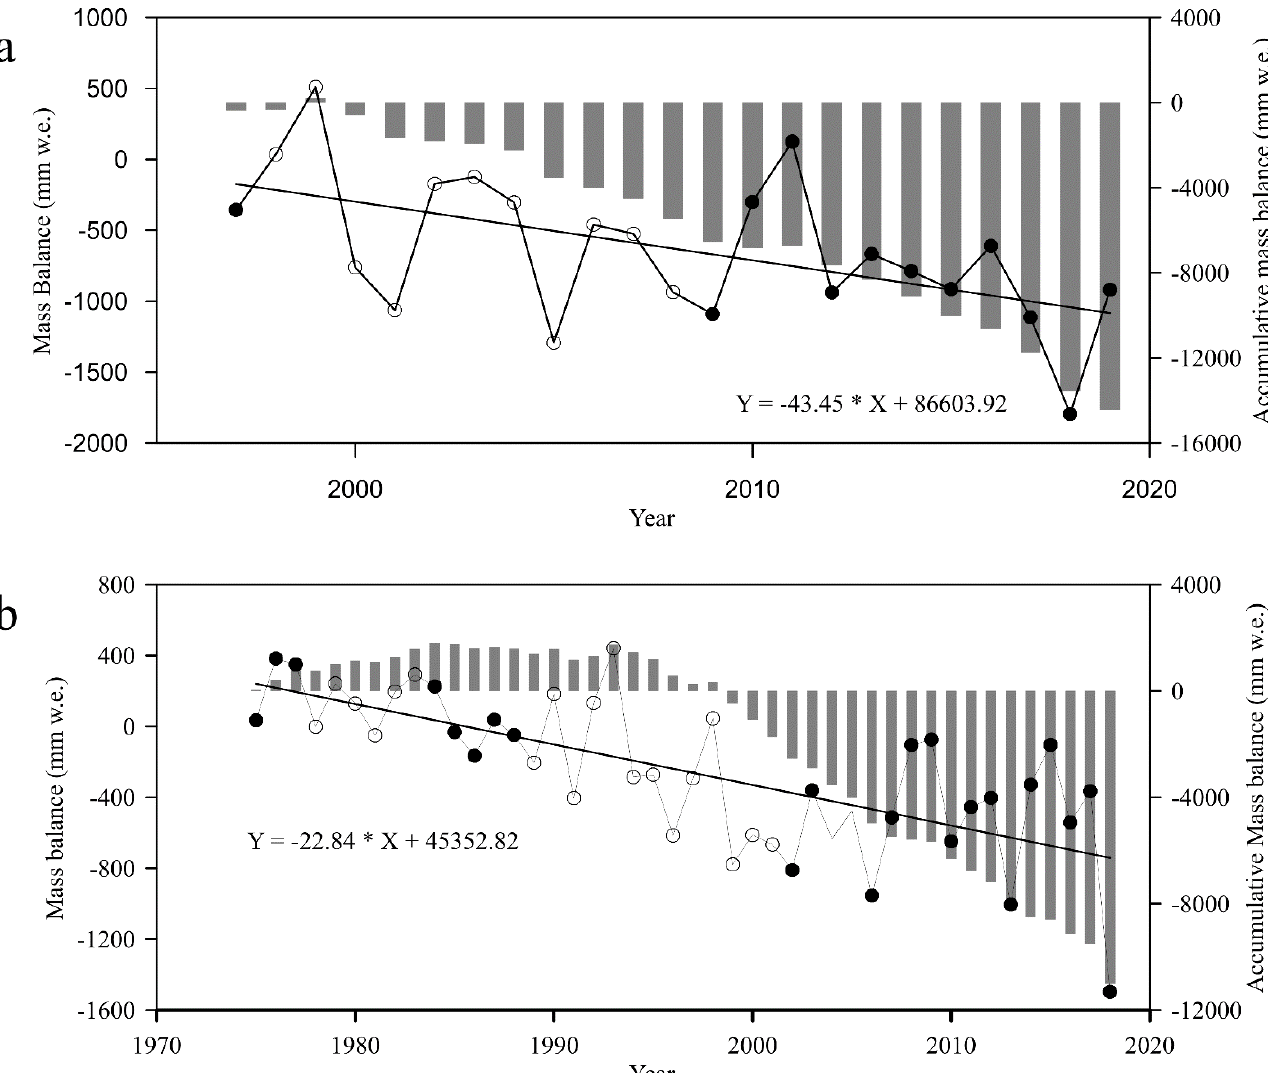
Figure 6. The modeled glacier mass balance changes of the of the Yala Glacier and Qiyi Glacier. In the figure, ( a ) is for the modeled glacier mass balance changes of the Yala Glacier and the ( b ) for the modeled glacier mass balance changes of the Qiyi Glacier.